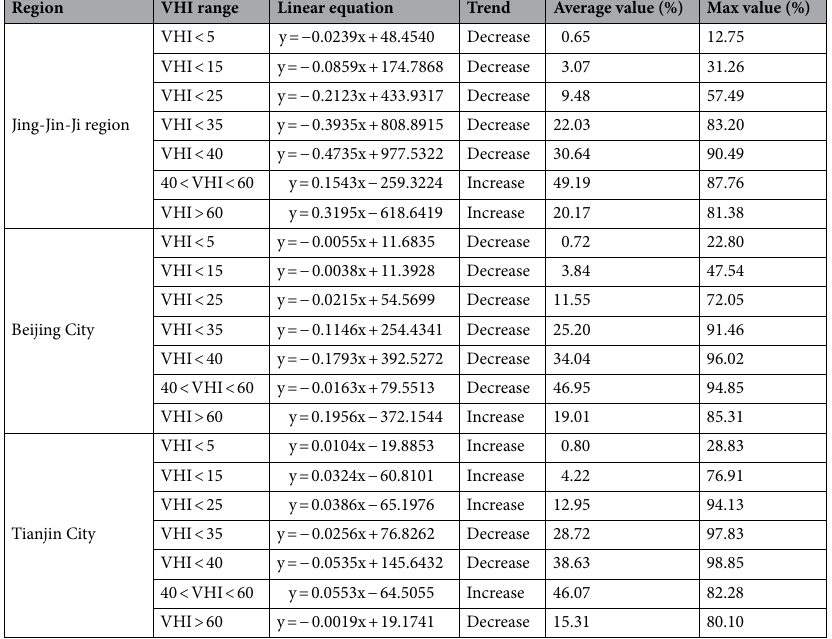
Table 2. Liner trends of percentage of area with regional average weekly VHI at different ranges for the period of 1982–2016 in Jing-Jin-Jin region, Beijing and Tianjin cities.